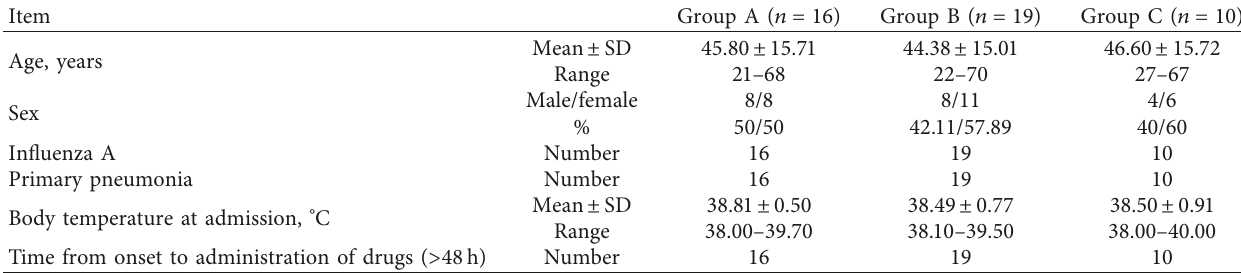
Table 2: General characteristics of the study